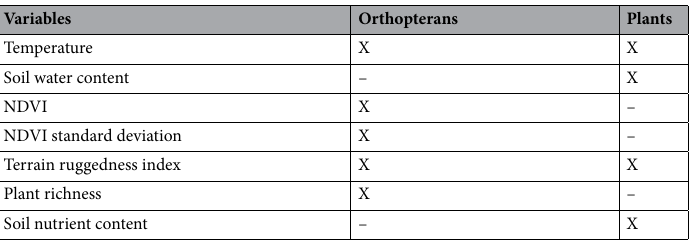
Table 2. Alternative environmental variables considered in the study to explain elevational species richness patterns. “X”: Variable included in the models; “–”: Variable not included in the models for not representing a hypothesis for the specified